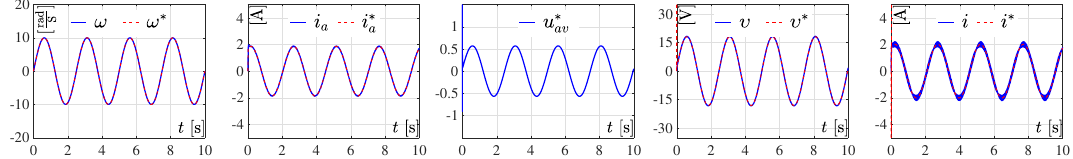
Figure 6. Circuit simulation results for a sinusoidal trajectory. The results of the mathematical model correspond to variables ω , i a , υ , i , whereas the results related to the reference variables are ω ∗ , i ∗ a , u ∗ av , υ ∗ , i ∗ .